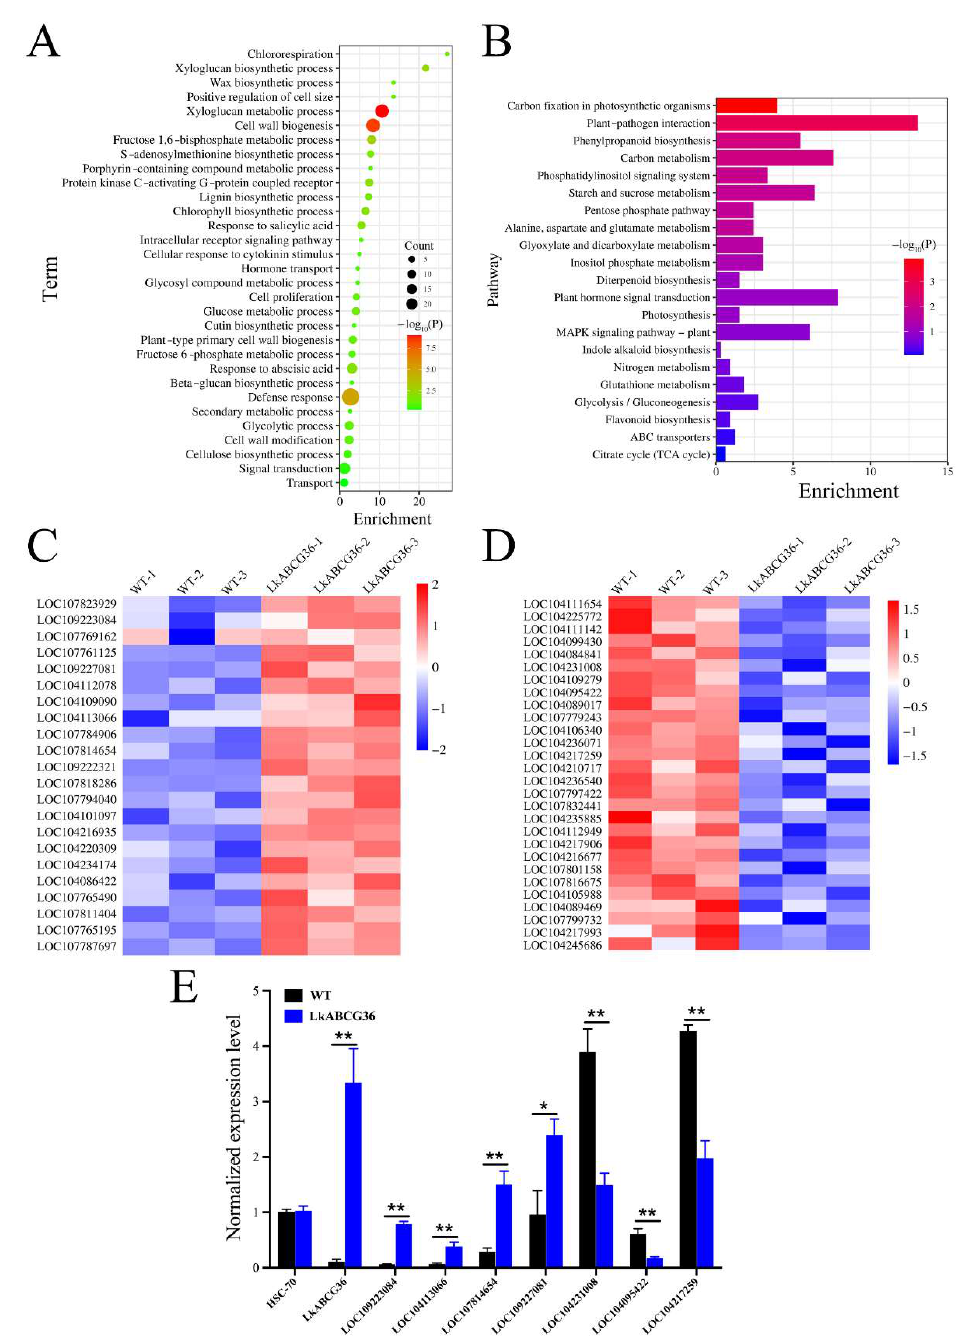
Figure 4. Functional enrichment analysis of DEGs and expression of key genes in LkABCG36 group. ( A ) Gene Ontology (GO) enrichment analysis identifiers in cluster of overlapping DEGs in LkABCG36 group compared with WT group. ( B ) Kyoto Encyclopedia of Genes and Genomes (KEGG) pathway enrichment analysis identifiers in cluster of overlapping DEGs in LkABCG36 group compared with WT group. ( C ) Heatmap shows key upregulated DEGs involved in biosynthesis of some secondary metabolites, energy metabolism, and plant hormone signal transduction. Relative expression level of genes was calculated using log10 (FPKM). ( D ) Heatmap shows key downregulated DEGs involved in biosynthesis of signal transduction and energy metabolism. Relative expression level of genes was calculated using log10 (FPKM). ( E ) We used RT-PCR to detect changes in key up- and downregulated DEGs in stem tissue of transgenic tobacco. Data reported as mean ± SEM. Significance levels are noted as * p < 0.05; ** p <